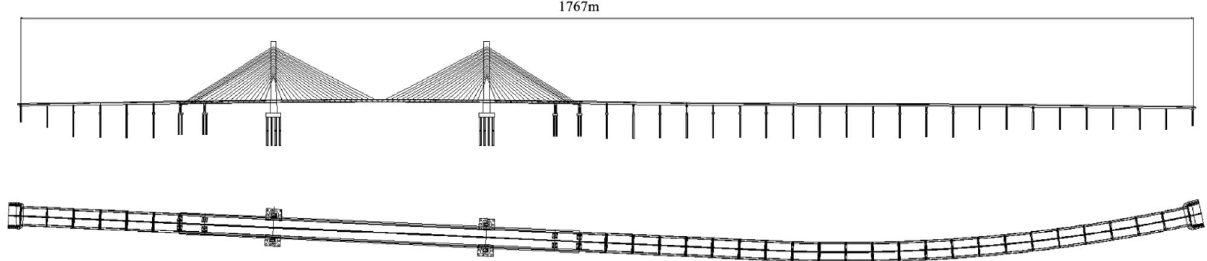
Figure 7. Plane linear drawing of the Cocodala